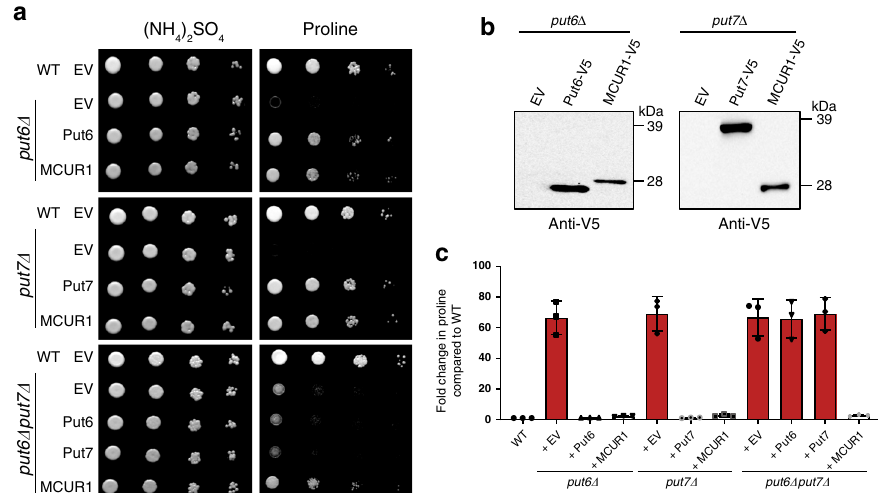
Fig. 7 MCUR1 can functionally complement put6 Δ and put7 Δ yeast mutants. a Indicated yeast strains were transformed with empty vector, Put6-V5, Put7-V5, or MCUR1-V5 expressing plasmids, serially diluted, and seeded on plates containing ammonium sulfate or proline as the sole nitrogen source. Images were captured after 3 days of growth at 30 °C. The data are representative of three independent experiments. b Mitochondria isolated from the indicated cells were subjected to SDS-PAGE immunoblotting analysis using anti-V5 antibody. Data are representative of two independent experiments. c Proline levels in WT and indicated yeast mutants cultured in proline-containing media. Relative proline levels were normalized to WT control and plotted as mean ± SD ( n = 3 biologically independent experiments). WT and mutants used in this panel are from prototrophic CEN.PK genetic background (see Supplementary Table 1). Source data are provided as a Source data fi